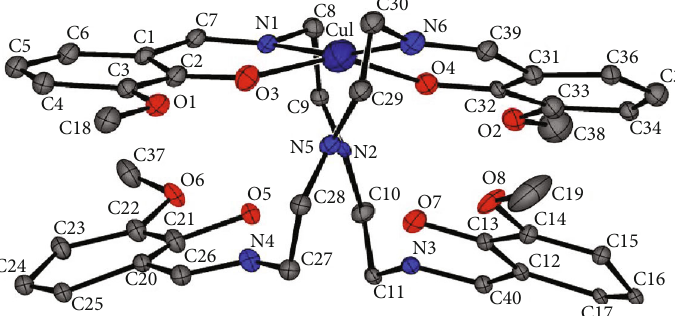
Figure 2: Molecular structure and atom numbering scheme for Cu(H